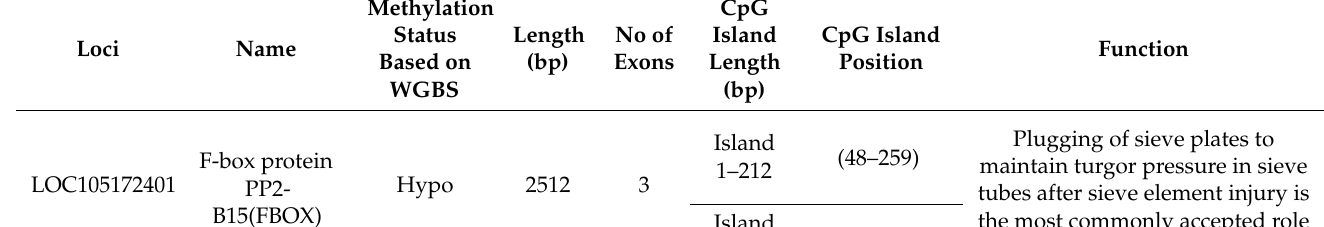
Table 2. List of selected loci used for methylation dependent restriction digestion and